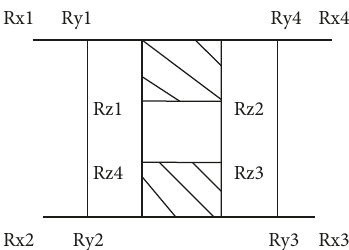
Figure 10: Basic structure of three-axis acceleration